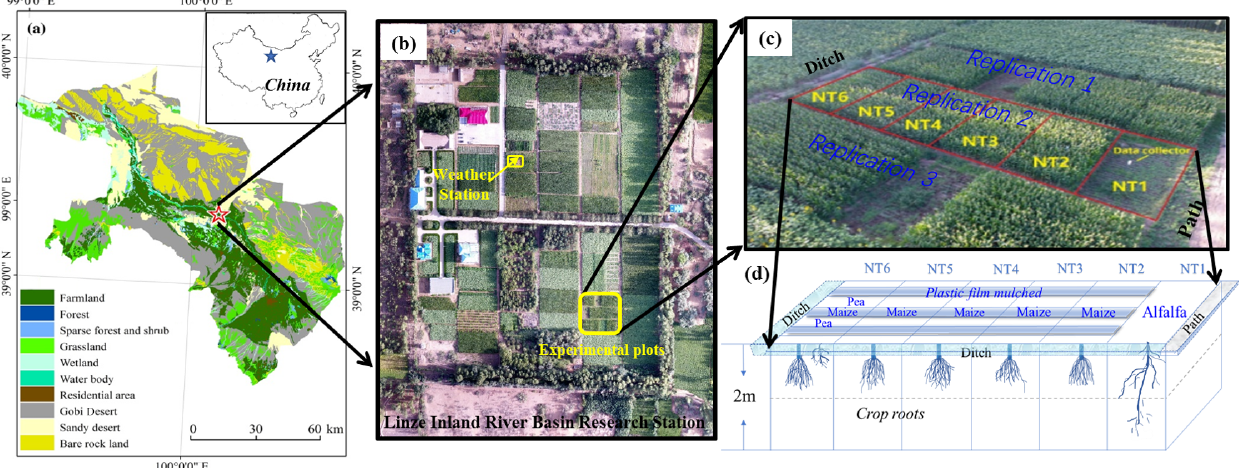
Figure 1. (a) Map of the study area and research site; (b) aerial view of the Linze Inland River Basin Research Station and (c) the study site; and (d) detailed design of the field experiments in